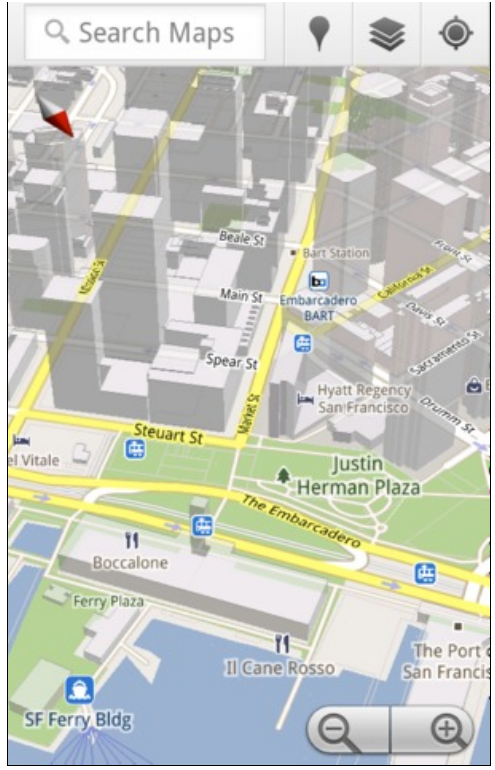
Figure 2: Google’s 3D Raster Mobile Mapping